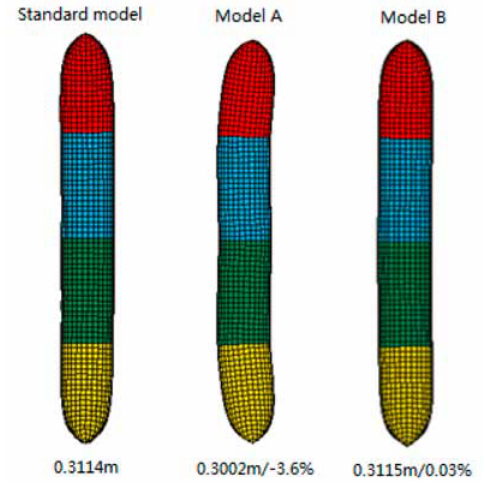
Fig. 13. Error analysis of the axial size after deployment